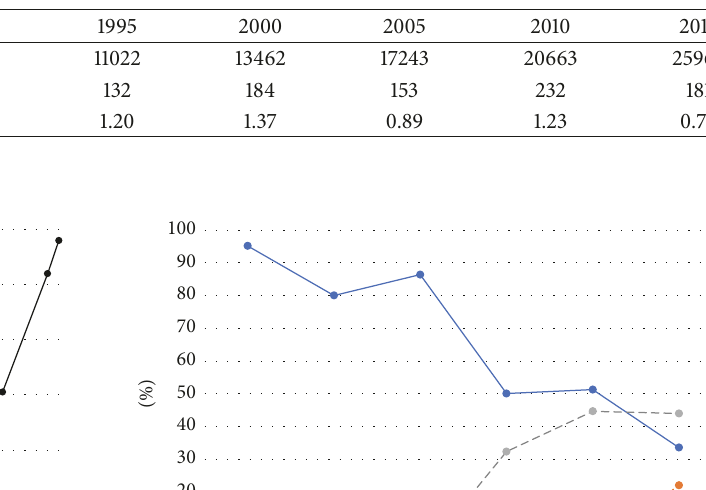
Table 2: Key hydroenergy statistics.